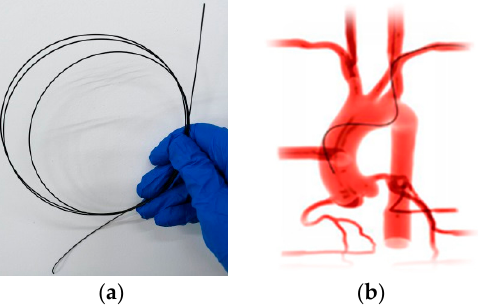
Figure 1. The guidewire: ( a ) Guidewire for interventional surgery; ( b ) Guidewire in a virtual blood vessel.